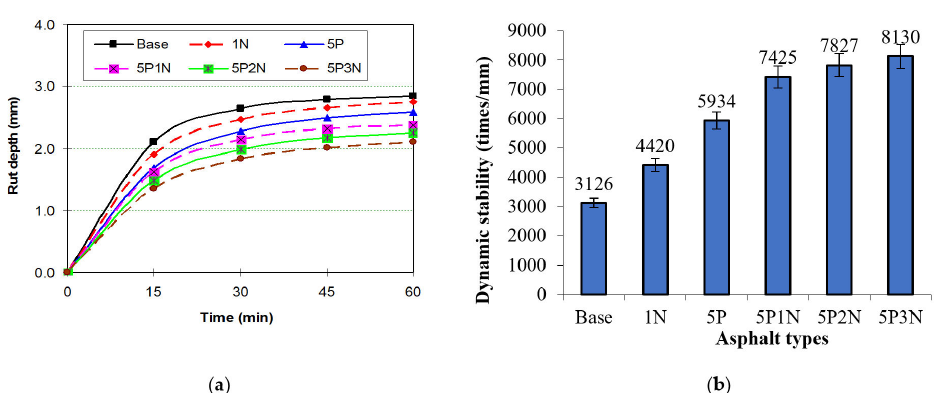
Figure 10. Relationship between PVC and NS content and rutting properties (( a )—rut depth, ( b )— dynamic